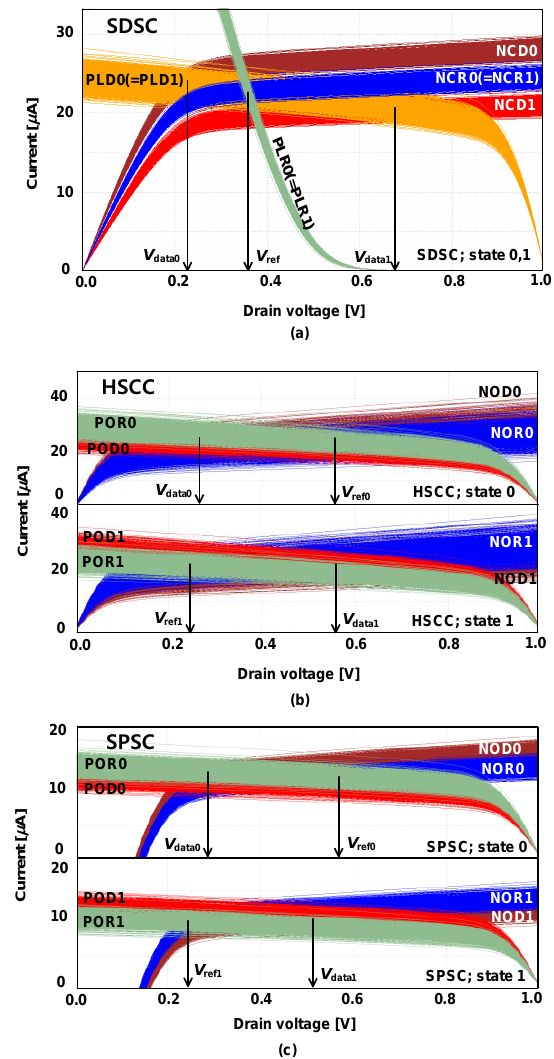
Figure 2. I-V curves of the conventional SCs with both MOSFET and MTJ process variations for analyzing operating point. ( a ) SDSC at states 0 and 1; ( b ) HSCC states 0 and 1; ( c ) SPSC at states 0 and 1.